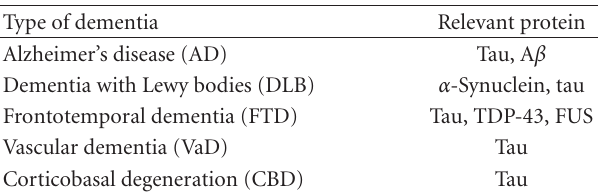
Table 1: Relevant proteins for each dementia (see text for refer- ences).